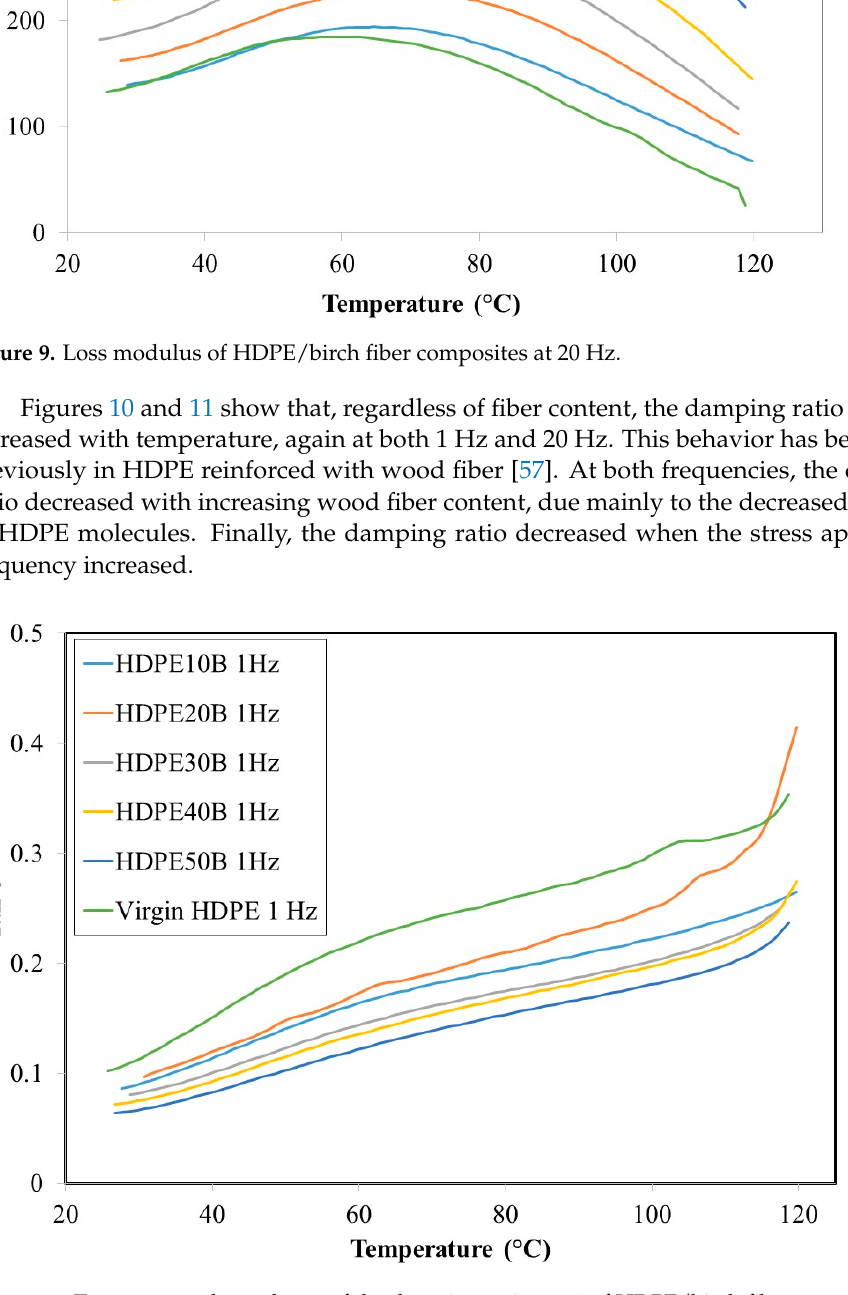
Figure 10. Temperature dependency of the damping ratio tan ó of HDPE/birch fiber composites at a stress frequency of 1 Hz.